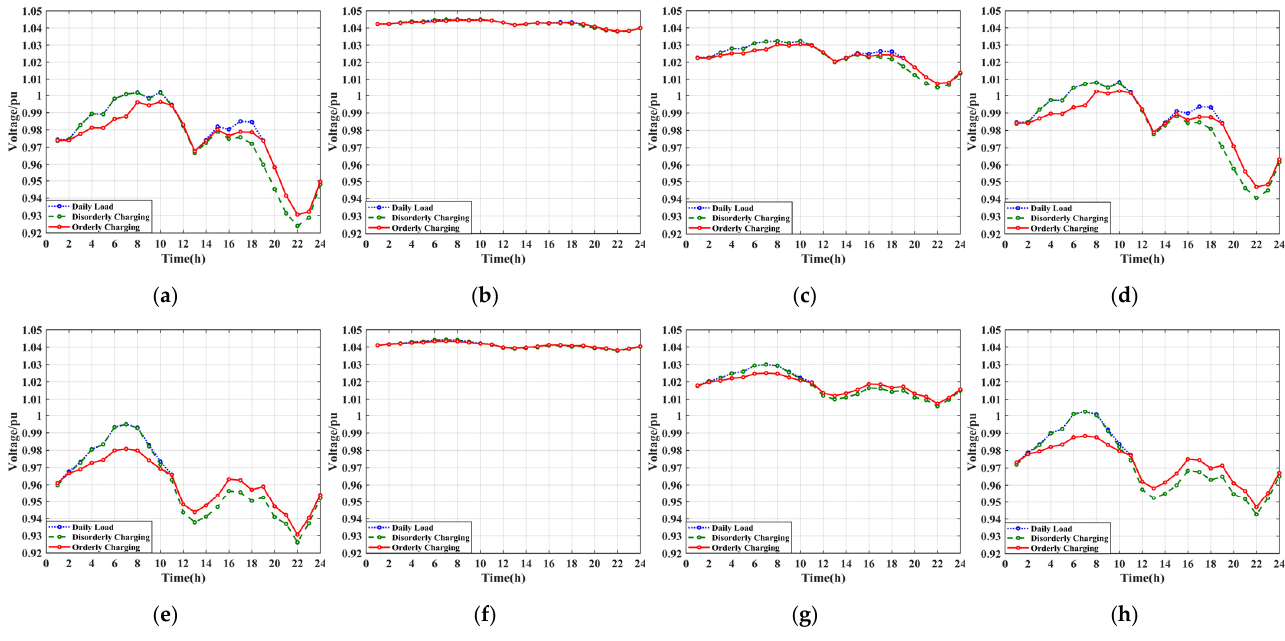
26 (weekday), ( e ) Node 2 (weekend), ( f ) Node 3 (weekend), ( g ) Node 7 (weekend), ( h ) Node 26 (weekend).